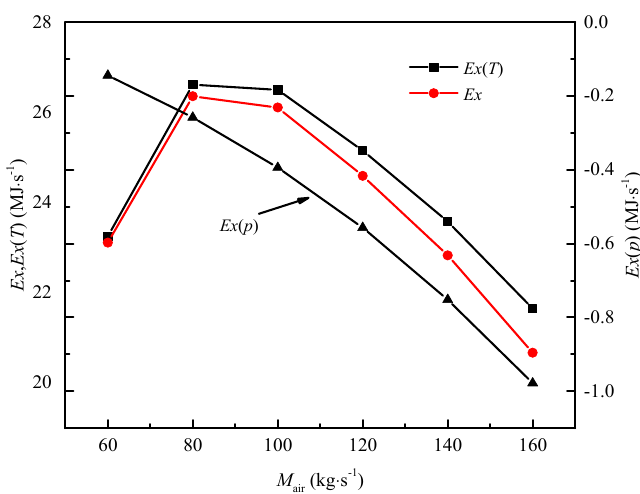
Figure 6. Effects of the air mass flow rate on enthalpy exergy Ex , temperature exergy Ex ( T ), and pressure exergy Ex ( p ).